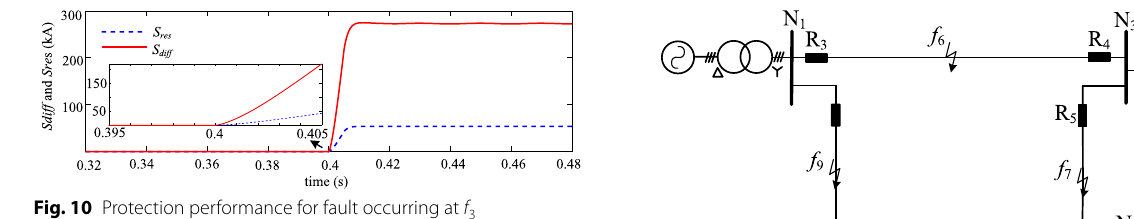
N when asymmetric faults 3 4